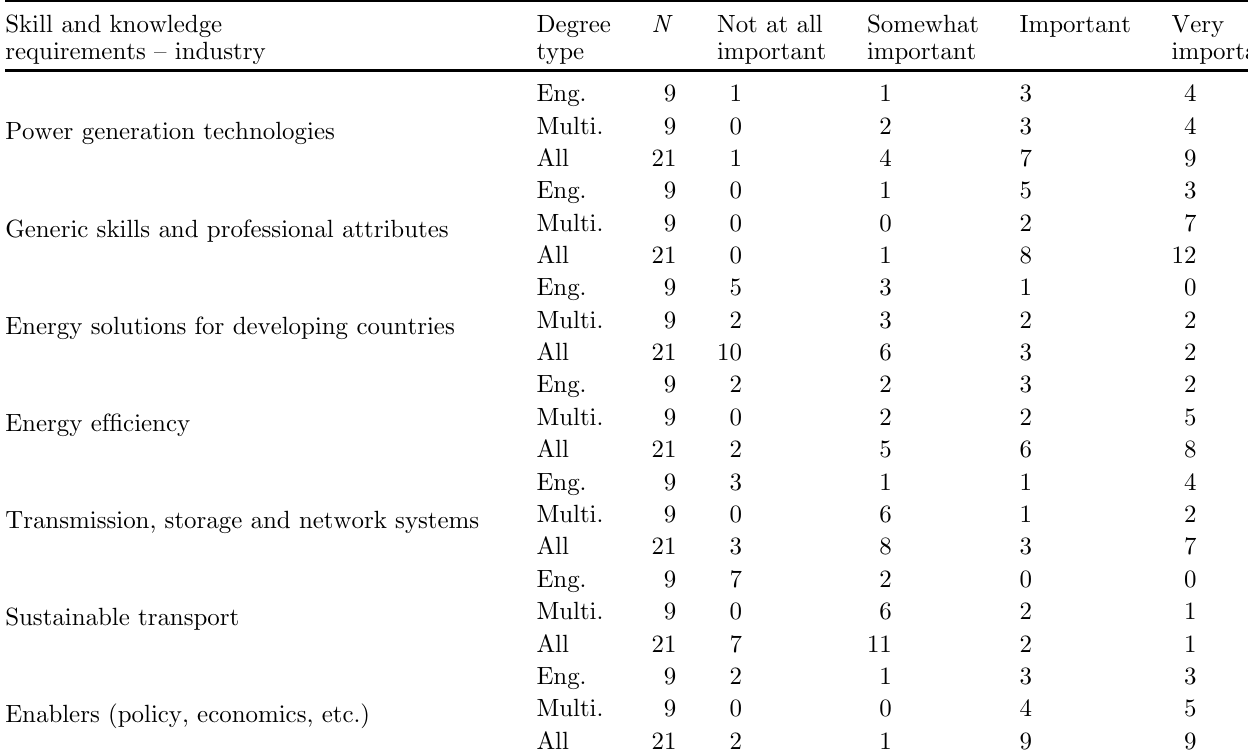
Table 2. Employer ratings of the importance of each of the main sustainable energy skills and knowledge